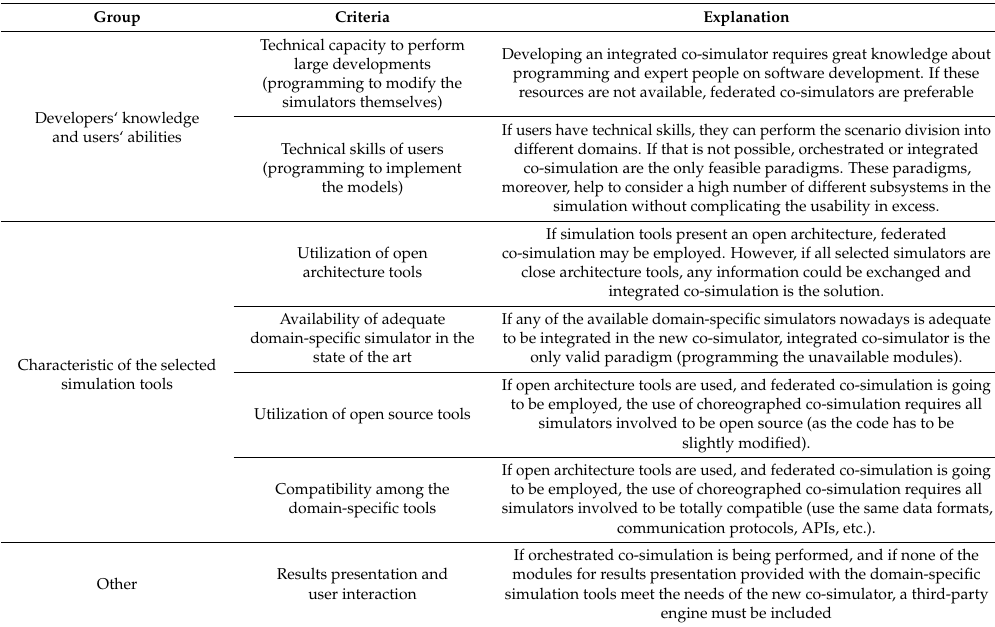
Table 6. Criteria for the selection of a co-simulation